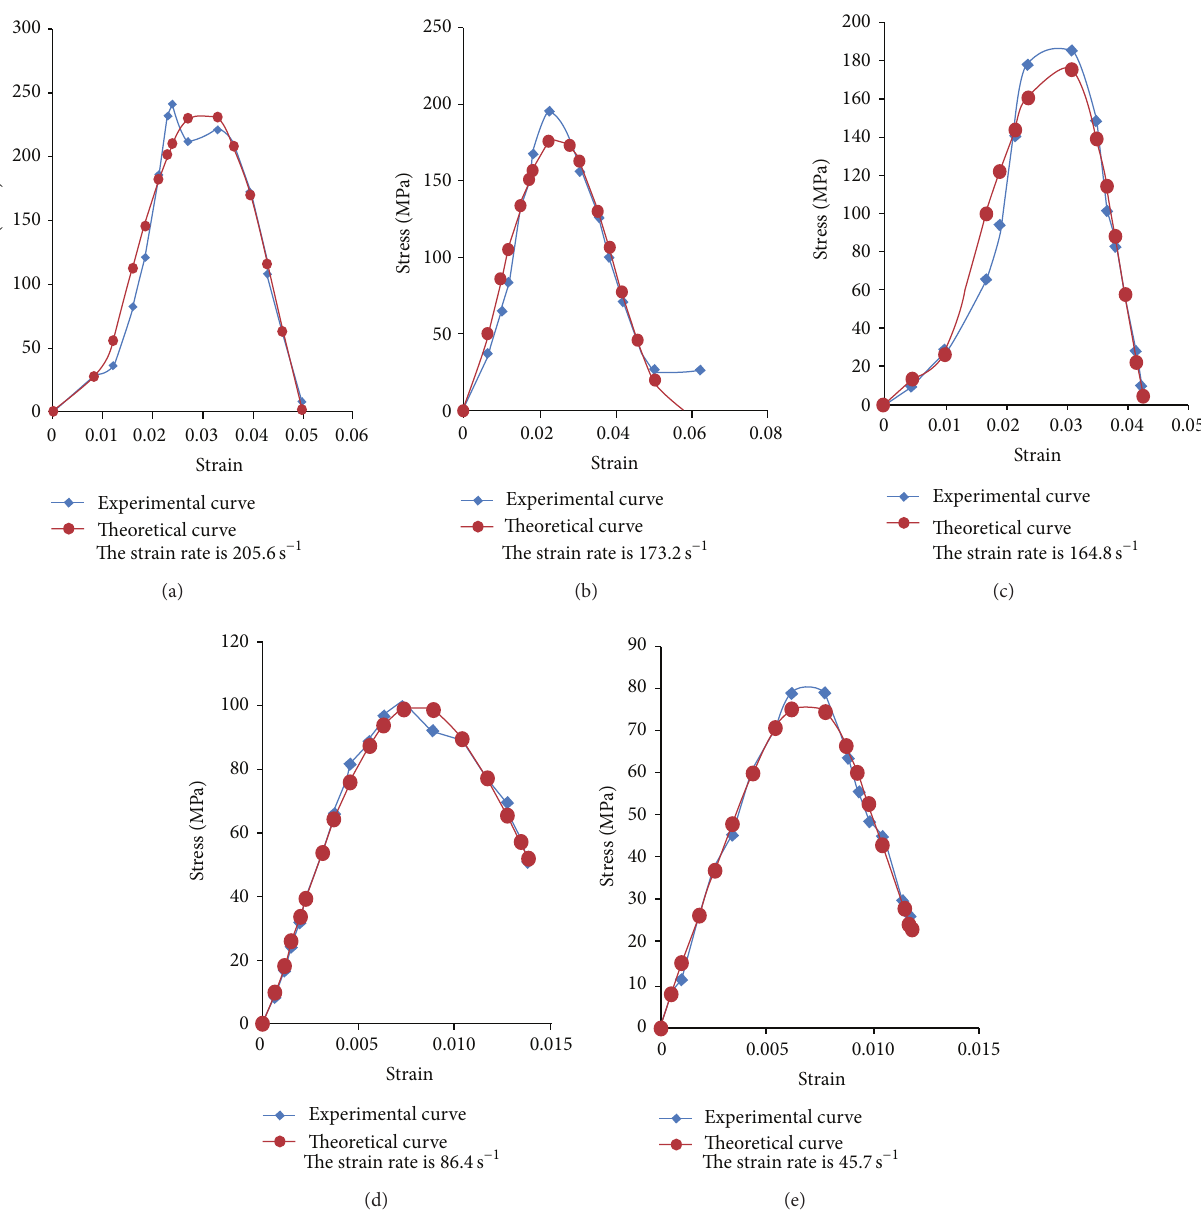
Figure 8: Comparison of theoretical curve and experimental